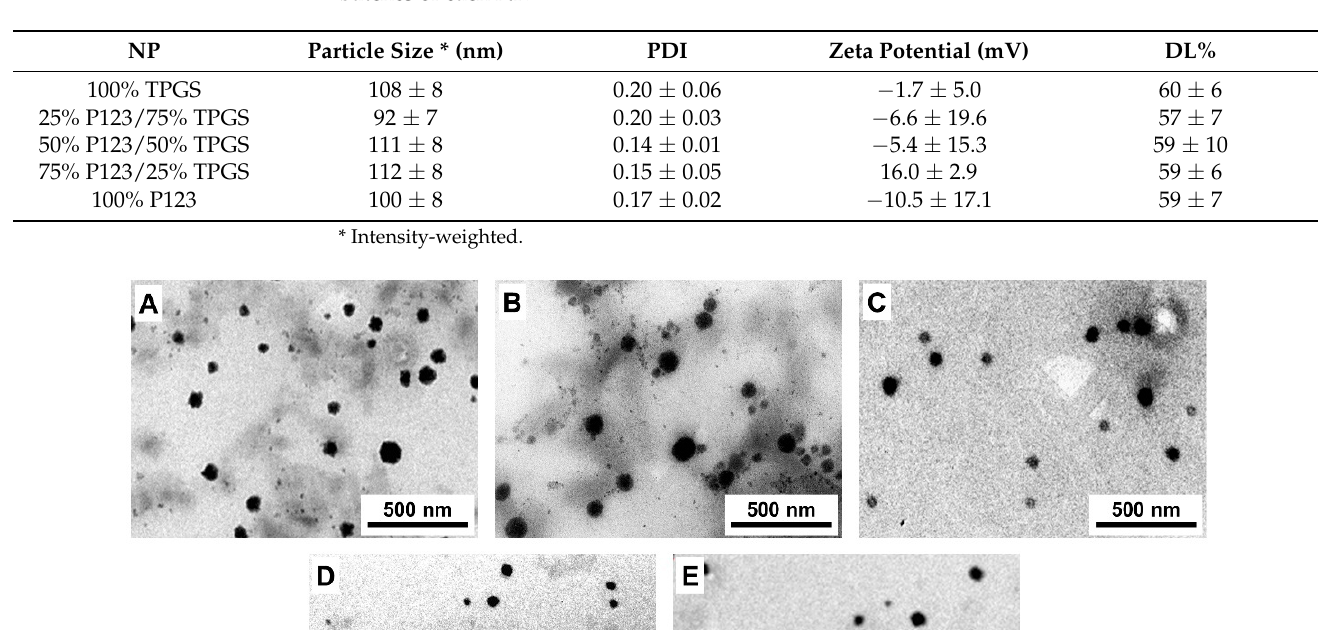
Table 2. Characteristics of R19-loaded NPs reported as the mean ± SD of at least three different batches of each NP.